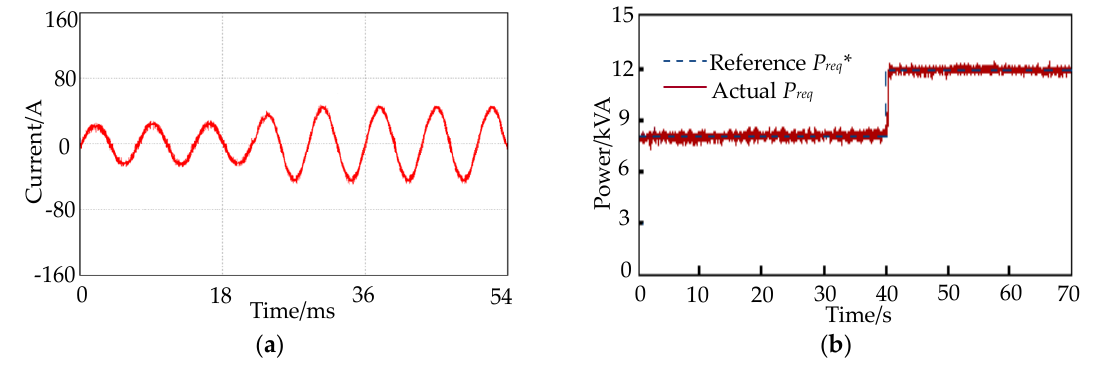
Figure 15. Simulation waveforms of transient response at P req * change. ( a ) Generator output current; ( b ) Output power.